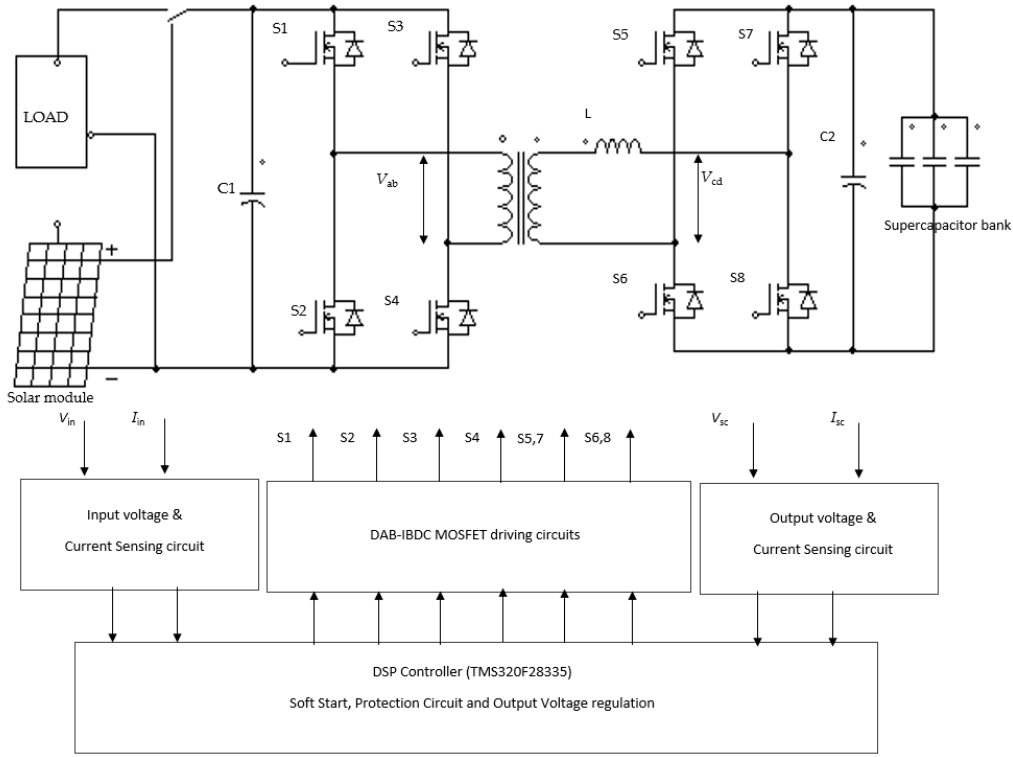
Figure 2. Schematic diagram of Digital Controlled Dual Active Bridge-Isolated Bidirectional DC-DC Converter (DAB-IBDC).